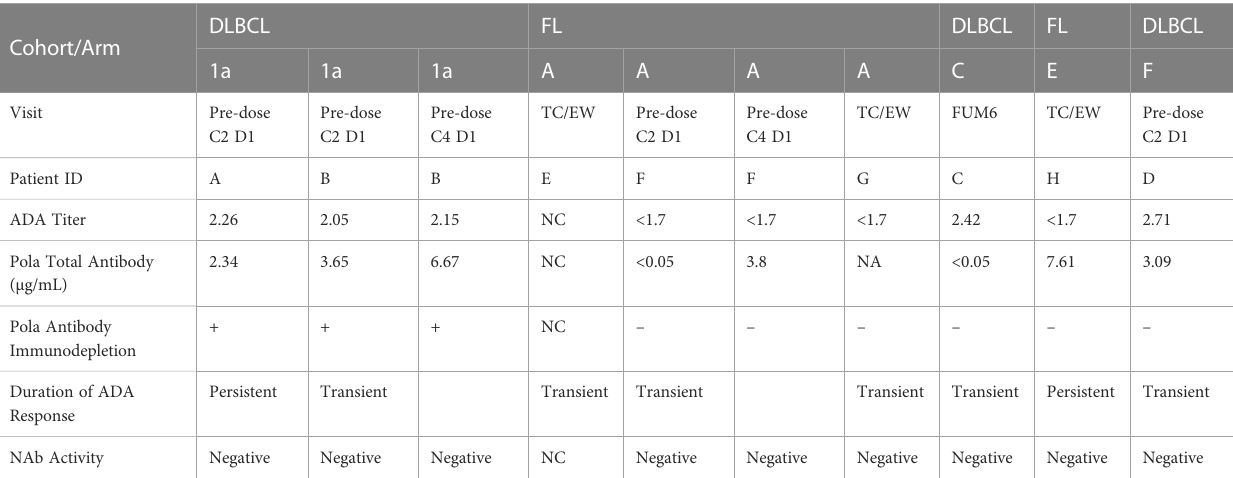
TABLE 3 Characterization of ADA positive samples in study GO29365.